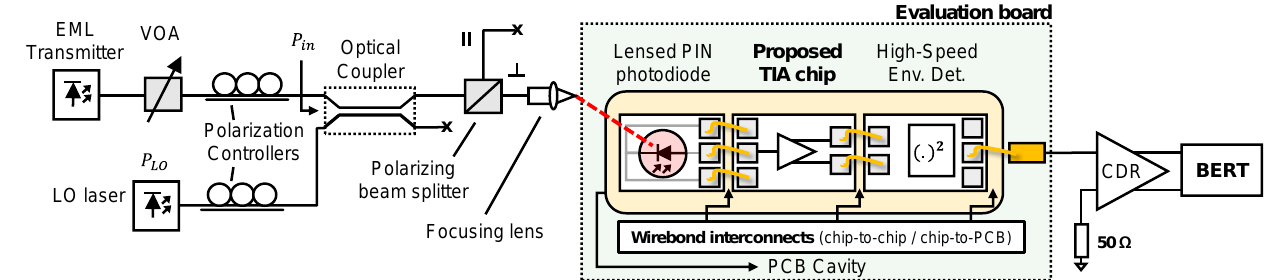
Figure 10. Single-polarization receiver setup used to evaluate the TIA performance.